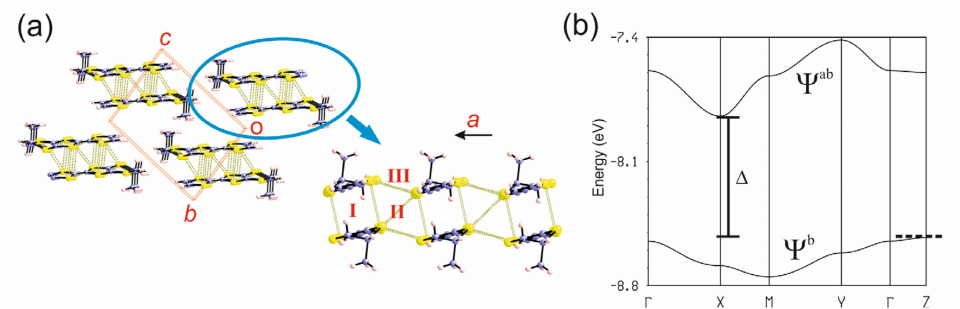
Figure 7. ( a ) Donor lattice of the [( rac )- 1 ]ClO 4 salt where the chains and the main intermolecular interactions are labeled; ( b ) Extended Hückel band structure for the donor lattice of [( rac )- 1 ]ClO 4 . The dashed line refers to the highest occupied level and Γ = (0, 0, 0), X = ( a * / 2, 0, 0), Y = (0, b * / 2, 0), M = ( a * / 2, b * / 2, 0) and Z = (0, 0, c * / 2). Table 4. Intermolecular S ··· S contacts shorter than 3.9 Å and absolute values of the β